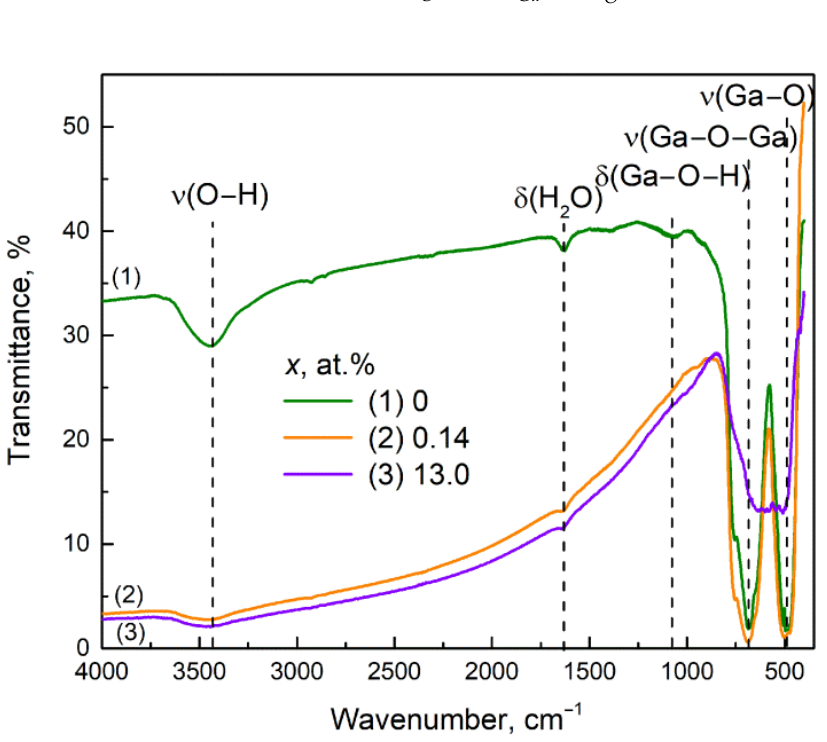
Figure 8. The FTIR spectra of Ga 2 O 3 (Sn) samples annealed at 750 °C.